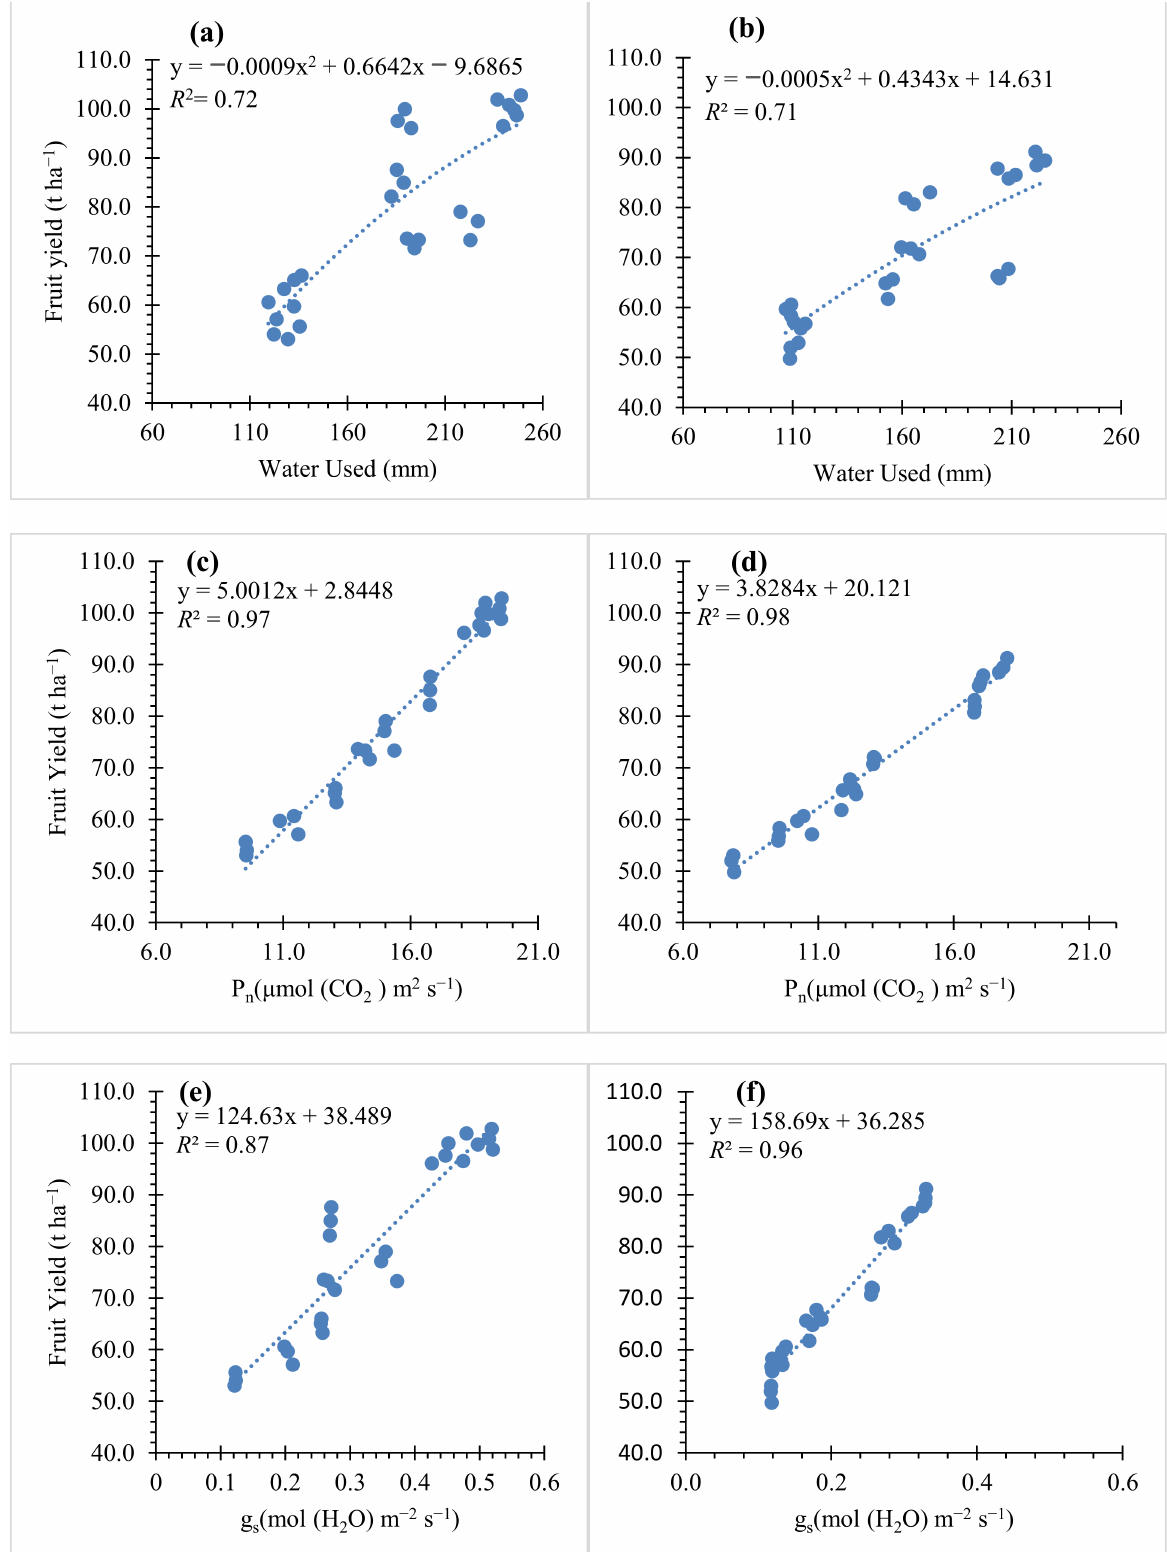
Figure 3. Regression models fitted for SS as ( a ) water used vs. fruit yield; ( c ) Pn vs. fruit yield; ( e ) gs vs. fruit yield, and for FW as ( b ) water used vs. fruit yield; ( d ) Pn vs. fruit yield; ( f ) gs vs. fruit